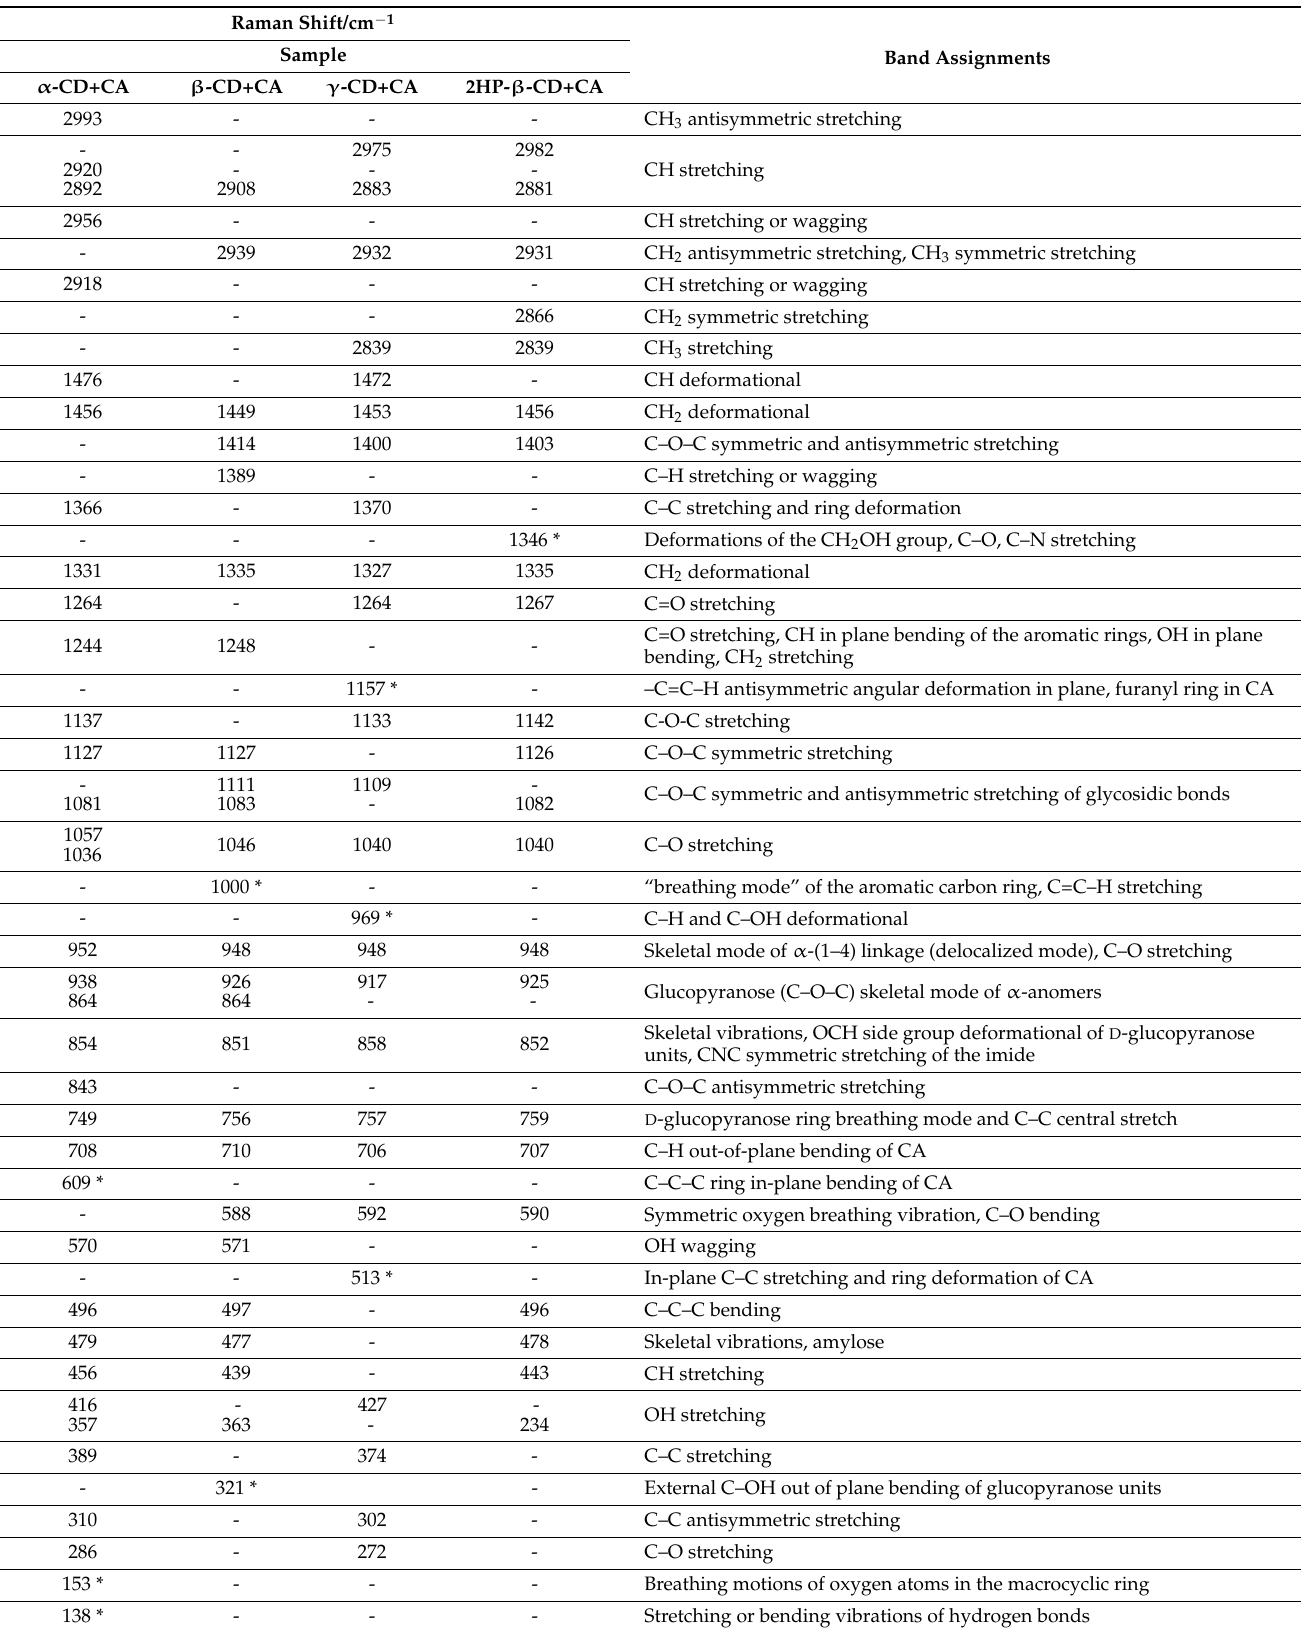
Table 2. The most significant bands recorded in the Raman spectra of studied CA–CD complexes (assignments were made in accordance with refs.